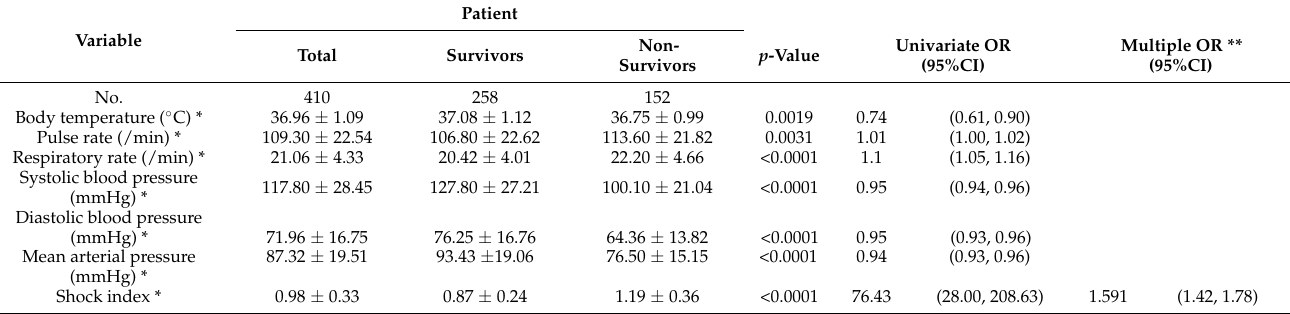
Table 2. Comparison of the clinical findings of patients, survivors versus non-survivors at 60 days after the index emergency department